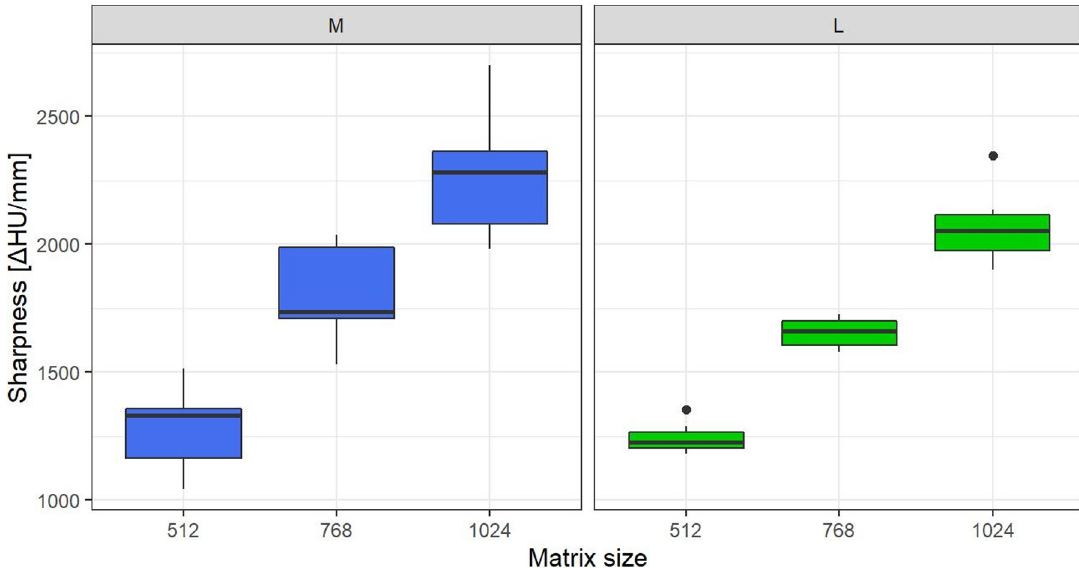
Fig 3. Results of image sharpness. Box plots show comparisons of image sharpness (as CT number increase per mm) among the three matrix sizes for the medium (M) and large (L) phantom sizes. Data was averaged for both radiation doses. Sharpness increased with matrix size for both sizes.